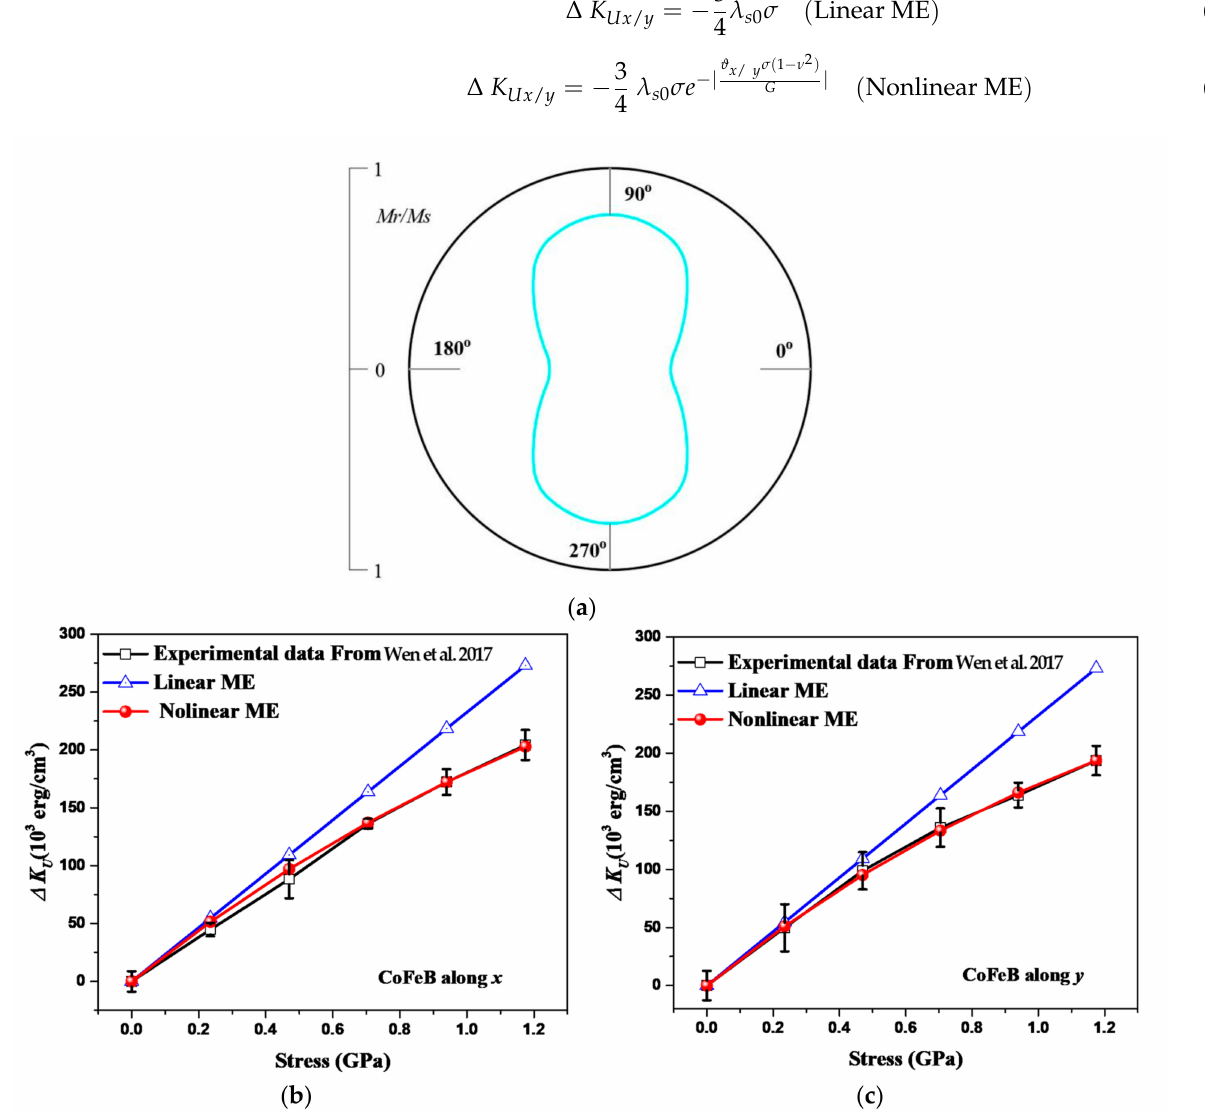
Figure 2. Comparison of the magnetic anisotropy constant variations in CoFeB by experiments [19] (Reproduced with permission from APPL. PHYS. LETT. 111(14), 142403 (2017). Copyright 2021 American Institute of Physics): ( a ) the definition of easy ( x ) and hard ( y ) magnetization directions, calculations by linear and proposed nonlinear ME (ME) along with x ( b ) and y ( c )